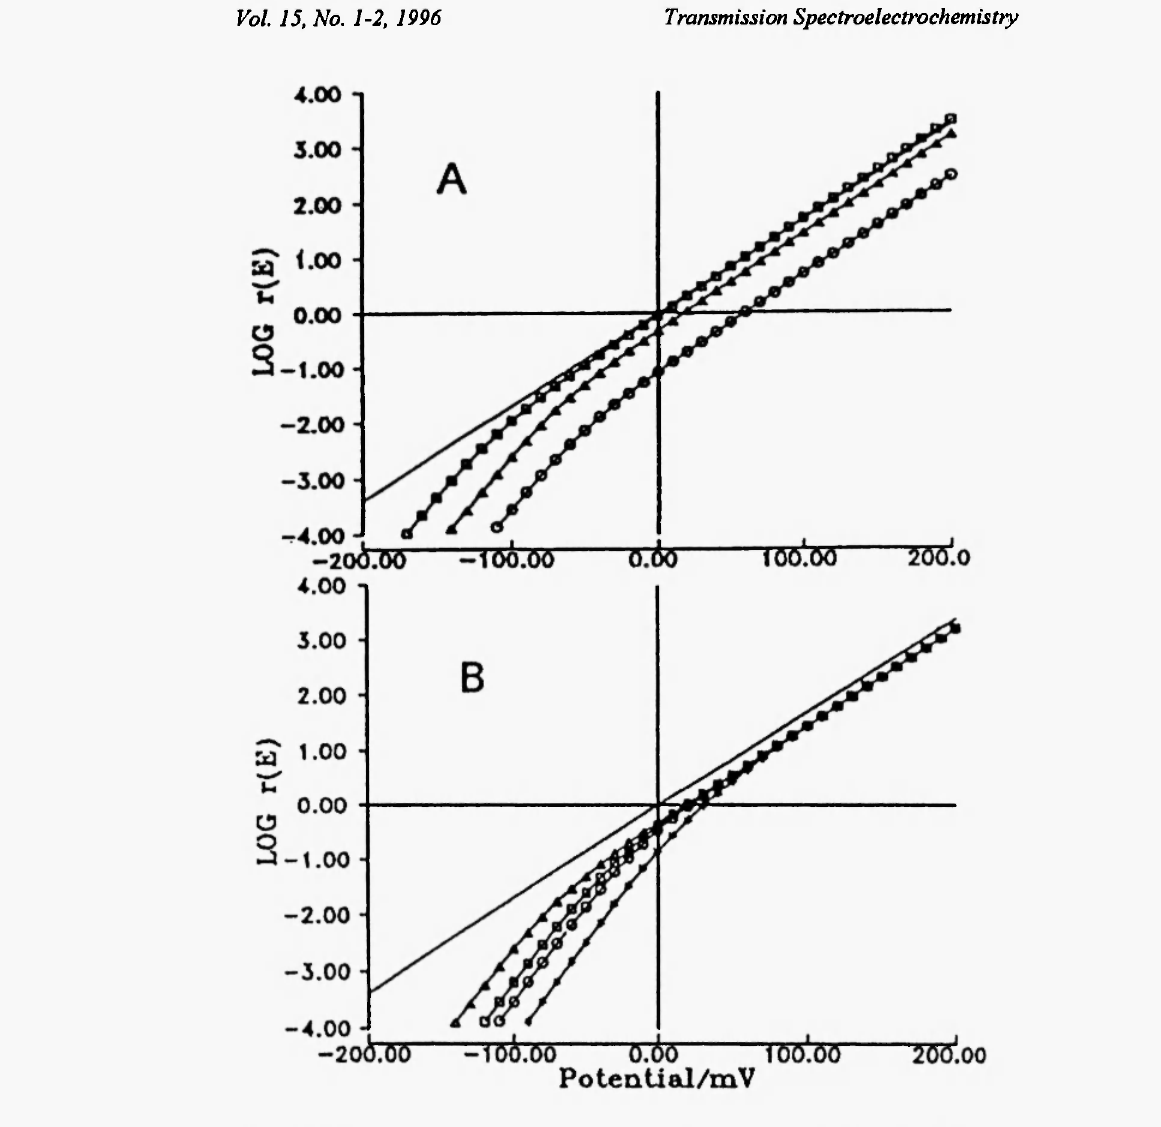
Fig. 27: (A) Influence of the equilibrium constants of the chemical reaction for the ECE mechanism on the Nernst plot (Ea/b" = 0 mV; «ι = n = 1, ε = 1 χ ΙΟ 3 , ε = ε = ε = 0; horizontal line, 2 Α Β 0 0 ln[r(£)] = 0; vertical line, E = 0): — Κ = 0, • Κ = 0.1; Α Κ = 1.0; Ο Κ = 10. (Β) Nernst plots for the ECE mechanism with various values of Εοό ' ~ 0; Κ = 1; n\ = n = 1; ε = 1 x 10 3 ; ε = 2 Α Β εο = e = 0; horizontal line, ln[r(£)] = 0; vertical line, Ε = 0; D inclined line, K = 0); Δ = -60 mV; • = -20 mV; Ο = 0; χ 20 mV (From Ref.